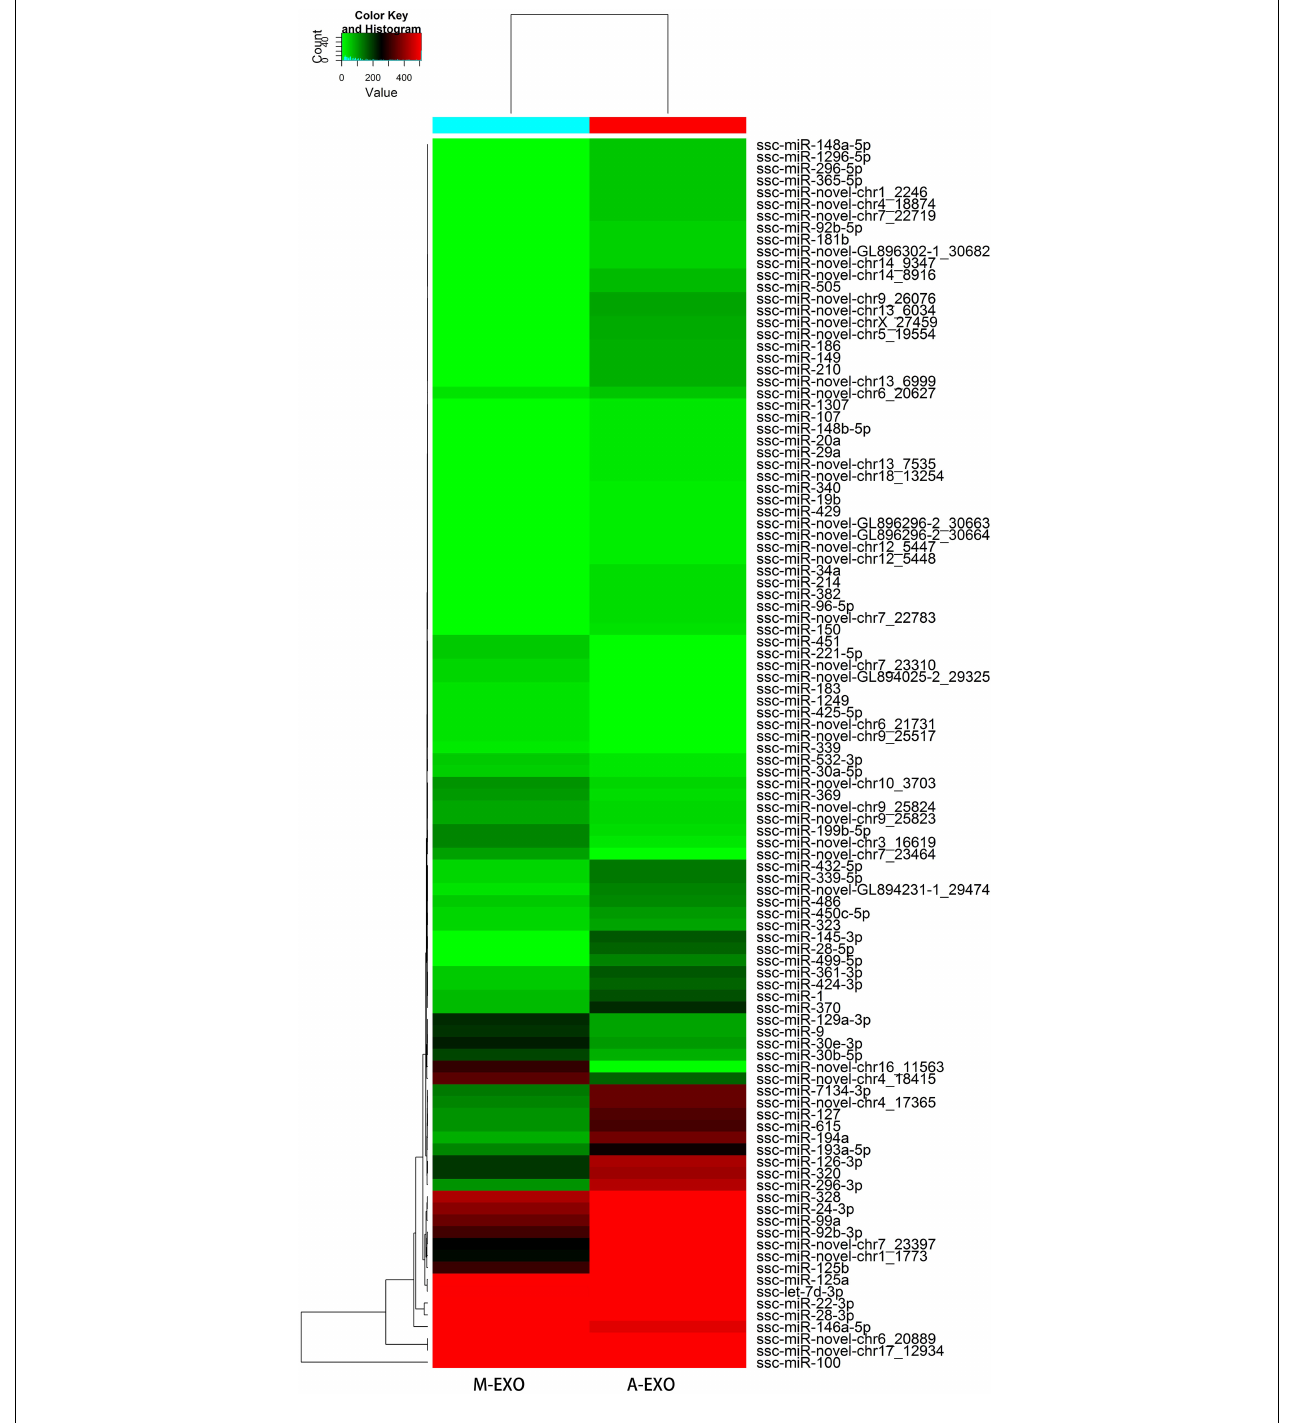
FIGURE 2 | Heatmap of miRNAs in M-EXO and A-EXO